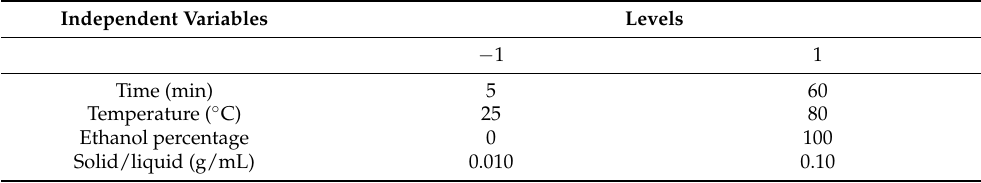
Table 4. Factors and relative extreme level applied to the experimental